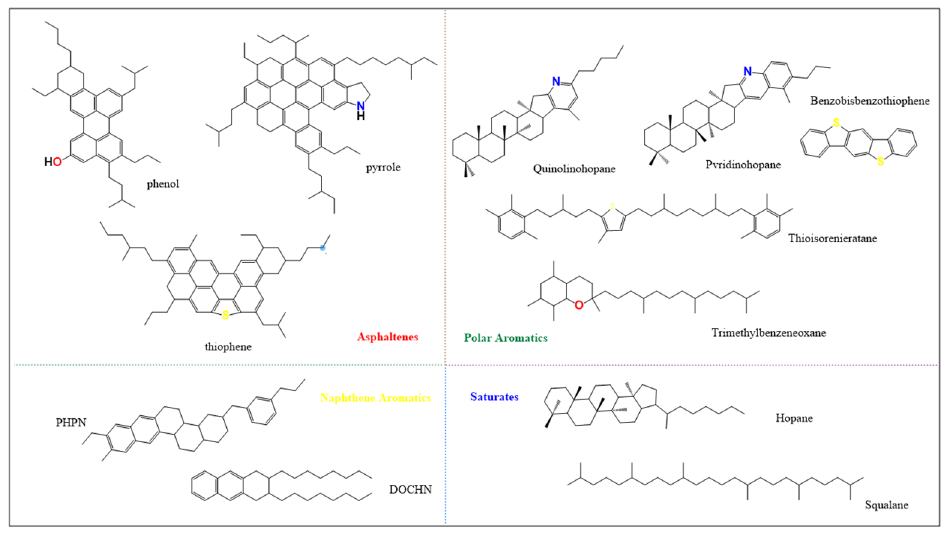
Figure 1. The four-component 12-molecule model of asphalt.